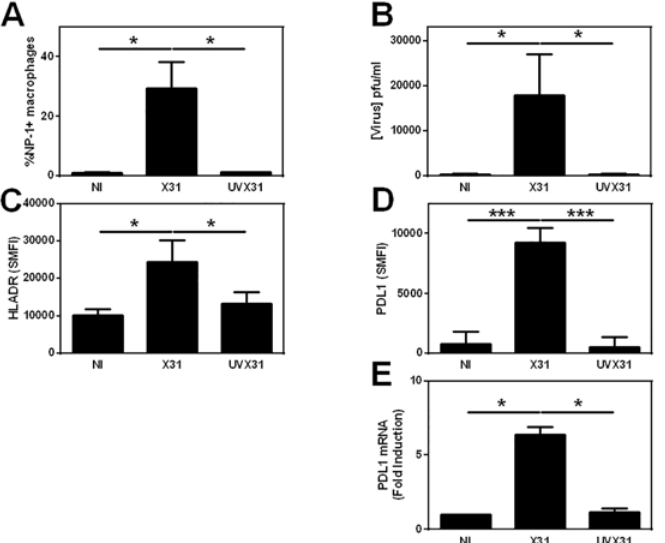
Fig 4. Infection of MDMs by X31. MDM were differentiated in the presence of 2 ng/ml GM-CSF for 12 d prior to infection with 500 pfu/ml of H3N2 X31 influenza virus or a UV-irradiated aliquot of virus (UVX31) for 2 h. After washing, media was replaced and the cells incubated for a further 22 h before supernatants and cells were harvested. Cells were analysed using flow cytometry and RT-PCR, supernatant was analysed using dot blot. Histograms showing infected MDM expression of A) Viral NP1 expression (% cells n = 7), B) release of hemagglutinin into supernatants (n = 10) C) cell surface HLA-DR expression (specific mean fluorescence intensity — SMFI n = 7) D) , PDL1 expression (SMFI n = 7) E) PDL1 gene expression (n = 6). Data are expressed as means ± SE of n independent experiments and analysed using a paired t-test * p < 0.05, ** p < 0.01. *** p <